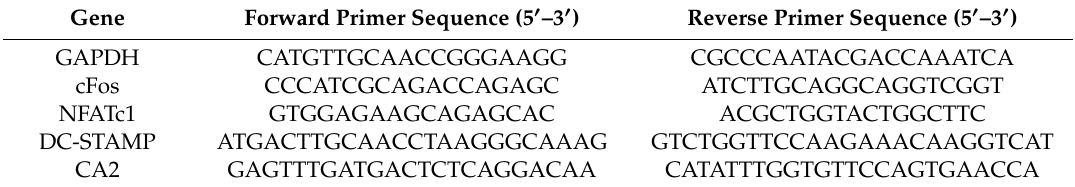
Table 2. Primers used for